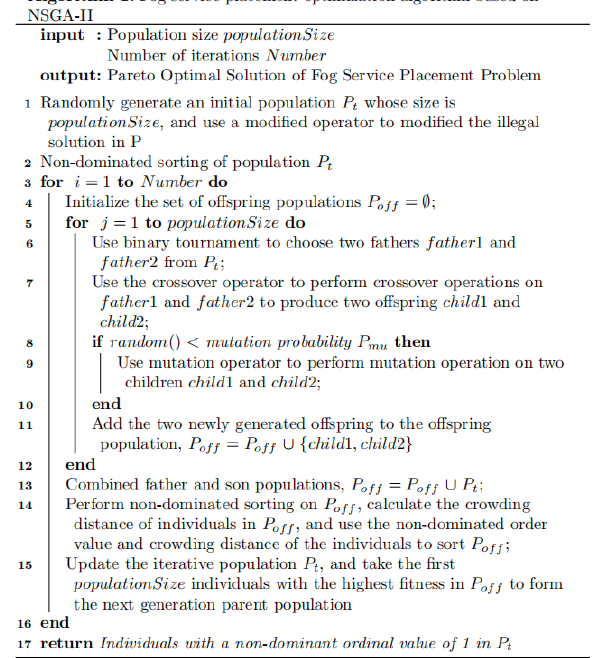
NSGA-II algorithm: fast non-dominated sorting operator and crowded distance.